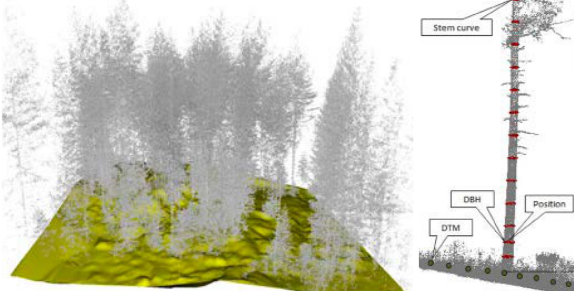
Figure 7. TLS in Forestry benchmark, Left: extracted DTM and point cloud of trees, Right: example of reference data: DTM, DBH, tree position and stem curve (tree height not